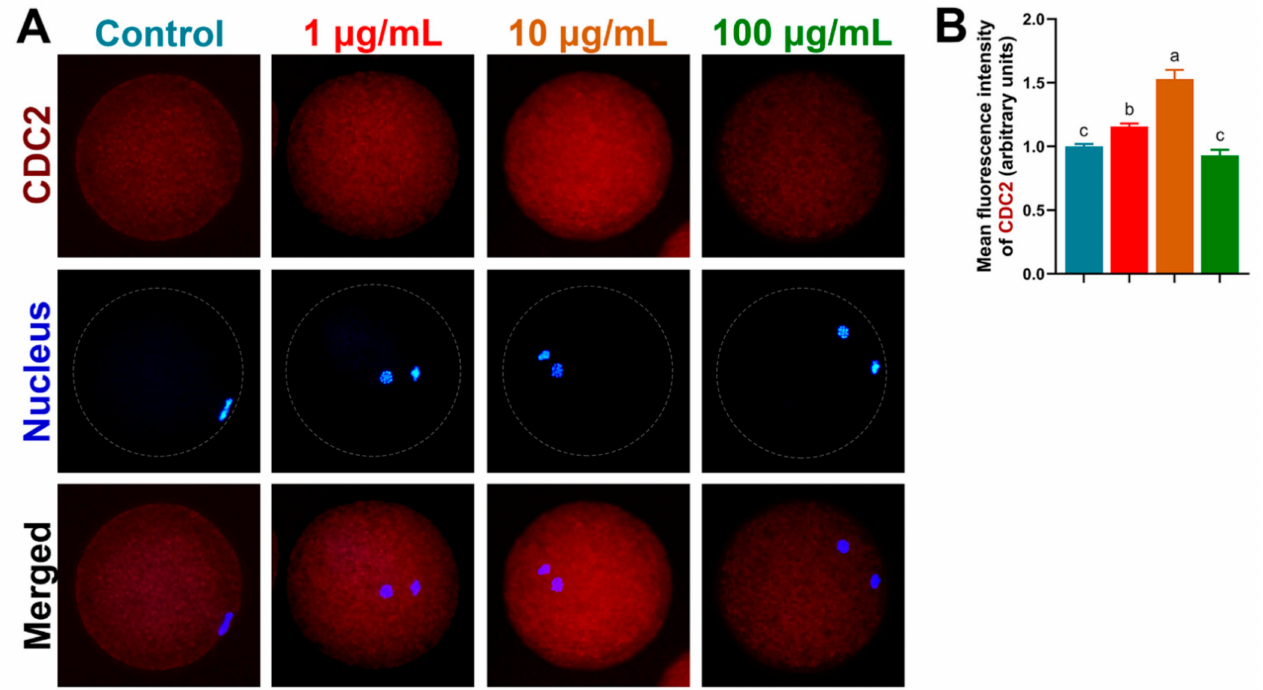
Figure 6. Expression of CDC2 protein detected by immunofluorescence ( A , B ). Bars with different letters denote significant differences ( p < 0.05). Results are shown as the average ± SEM of at least three repeats of independent